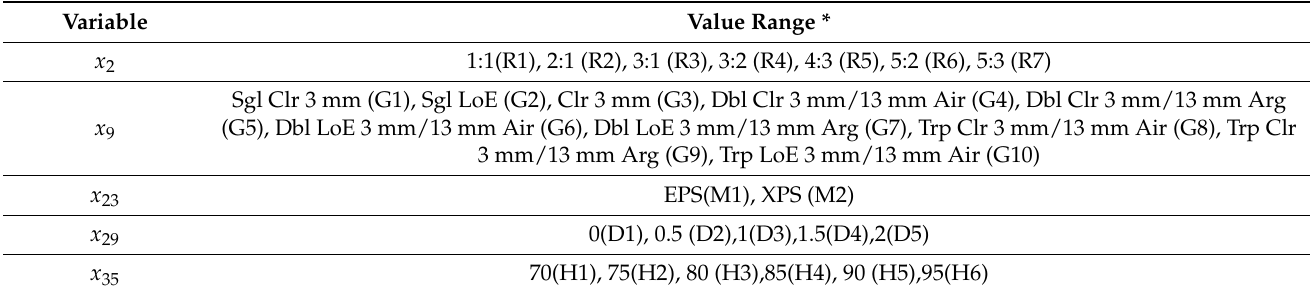
Table 4. Discrete variable